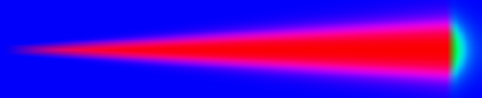
Figure 6: Occupancy triangle